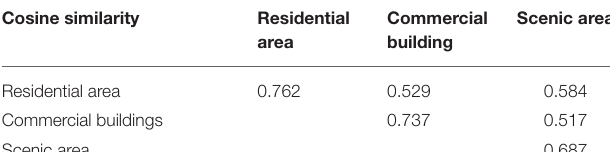
TABLE 2 | Trend similarity in different types of AOIs.